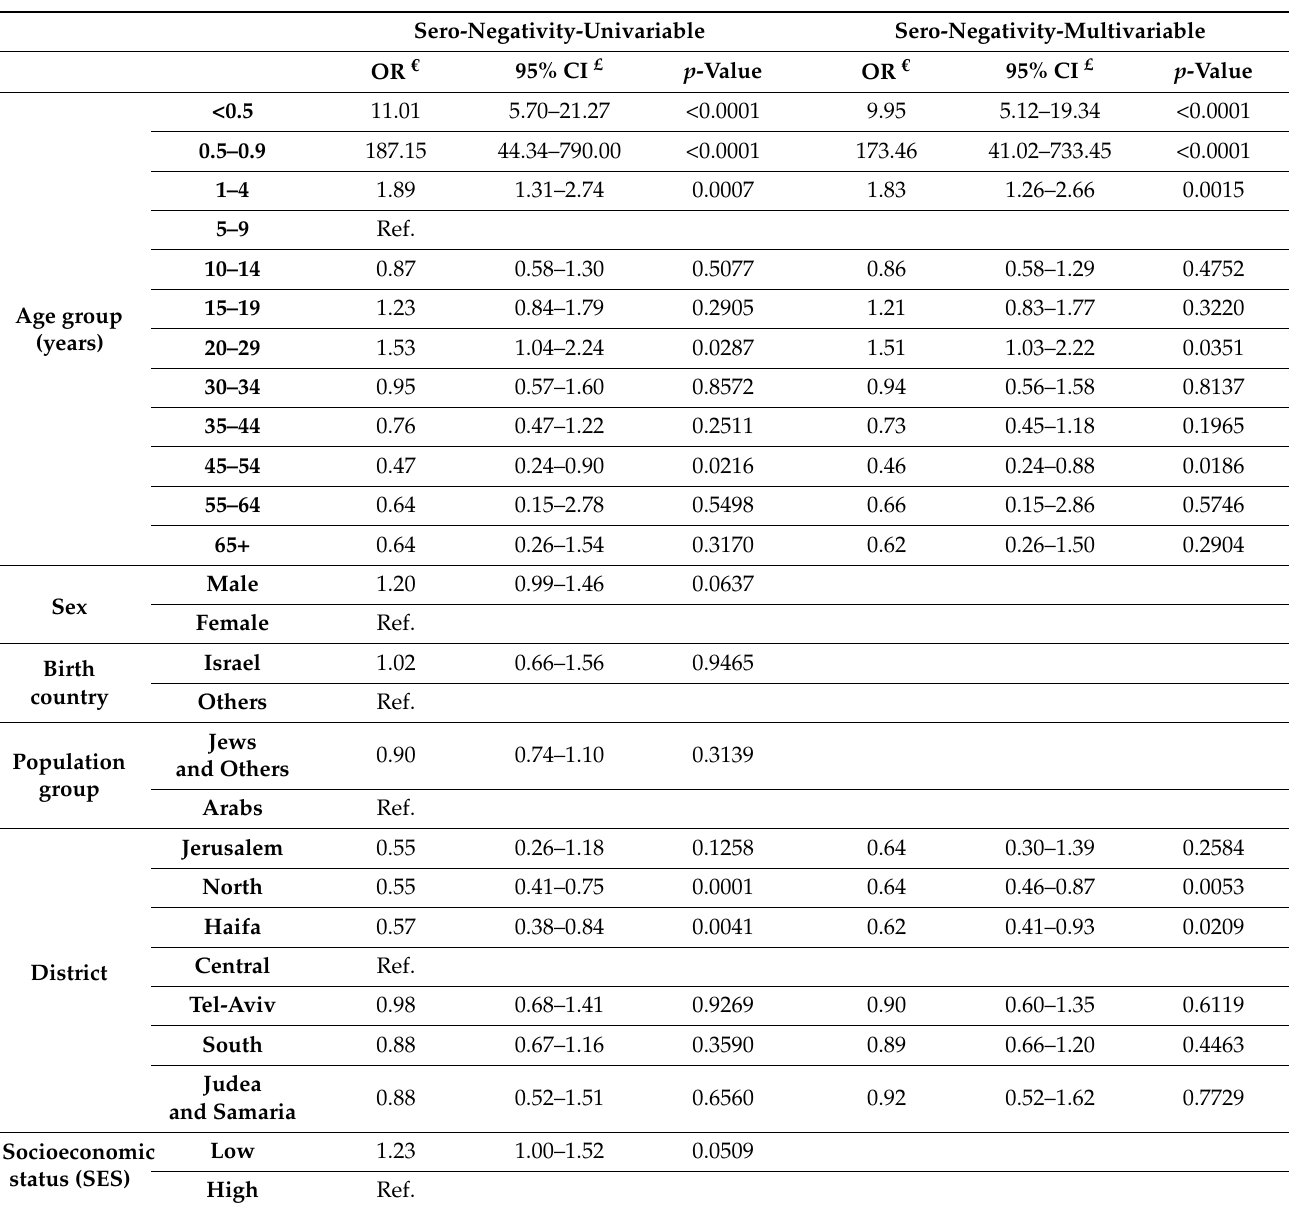
Table 2. The association between demographic characteristics and sero-negativity for mumps in Israel,